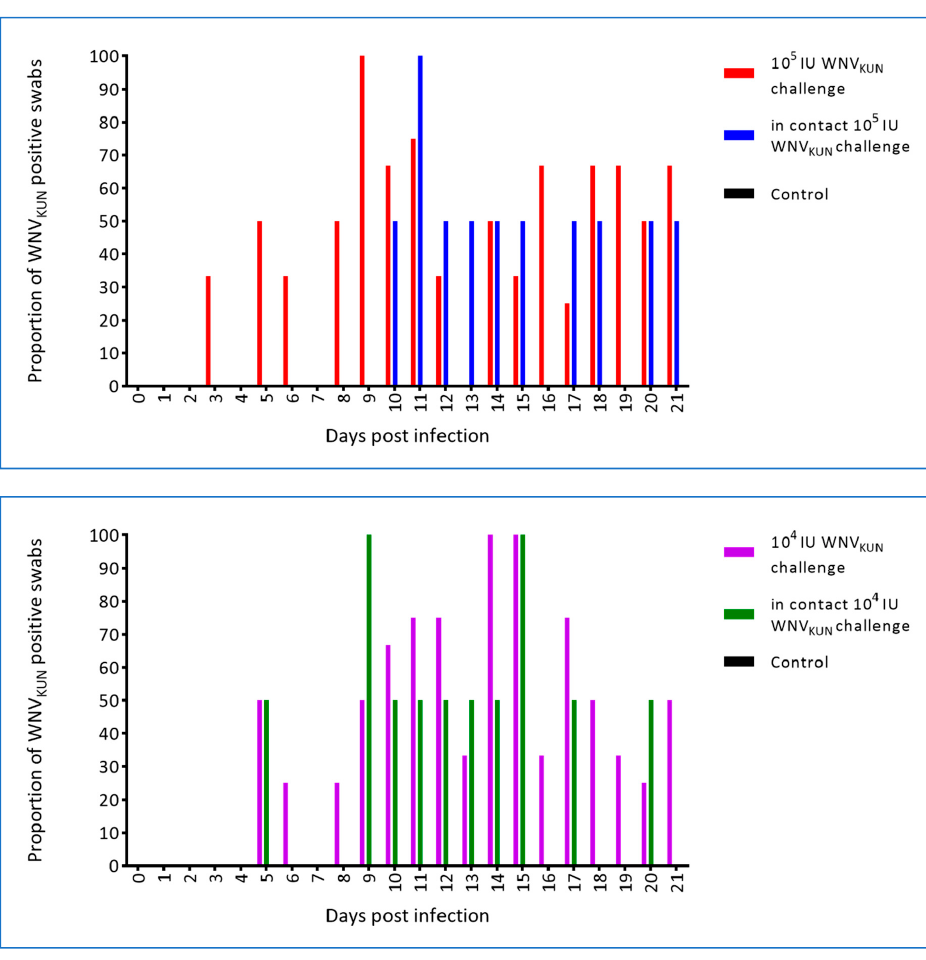
Figure 10. Proportion (%) of cloacal swabs positive for WNV RNA as determinaed by qRT-PCR with a cut-off of CT ≥ 40 [19]. Two in-contact hatchlings and three or four inoculated animals were sampled and tested each day. Viruses 2020 , 12 , 198